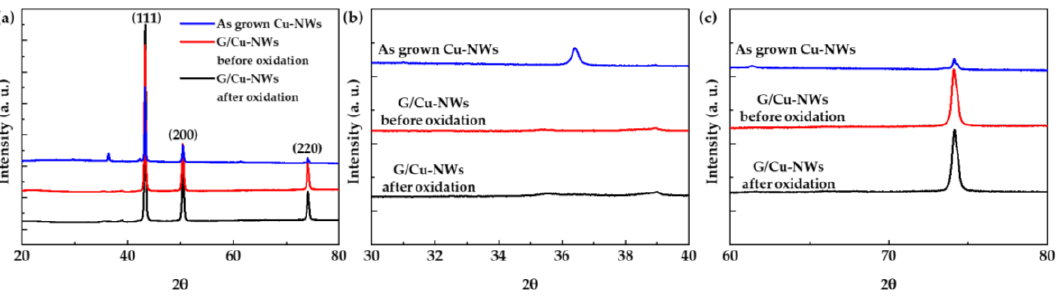
Figure 4. XRD spectra of as-grown Cu-NW and 20 sccm-CH 4 G / Cu-NW before and after oxidation; ( a ) full XRD spectra, ( b ) Cu 2 O and CuO peaks, and ( c ) CuO peaks.